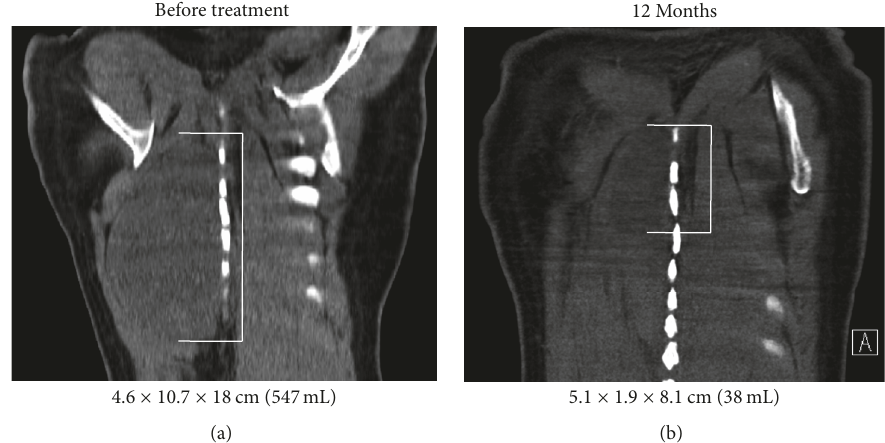
Figure 1: Imaging of Posterior Thorax Desmoid Treatment Response. Coronal CT of a right paraspinal desmoid tumor before (a) and 12 months after (b) completing radiation therapy to 50Gy in 25 fractions with concurrent imatinib demonstrating a significant reduction in tumor volume. The tumor is delineated with white brackets.